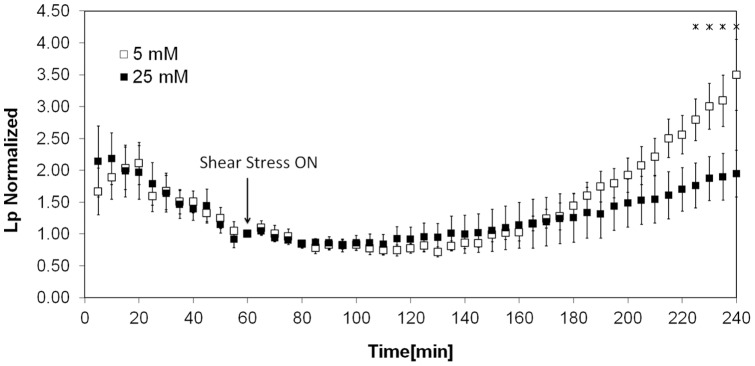
Normalized shear induced Lp response of BAEC monolayers grown in 5At time 02O was applied to the monolayers to drive water flow across them, and a baseline level was established after one hour. The Lp values were normalized to the baseline level for each monolayer. At time 60 min, a shear stress of 20 dyn/cm2 was applied and Lp recorded for three more hours. The monolayers that were treated with high glucose displayed a significant attenuation of the shear stress effect on Lp compared to controls (n = 6). The asterisks denote a significant differences between high glucose and control monolayers (p<0.05).